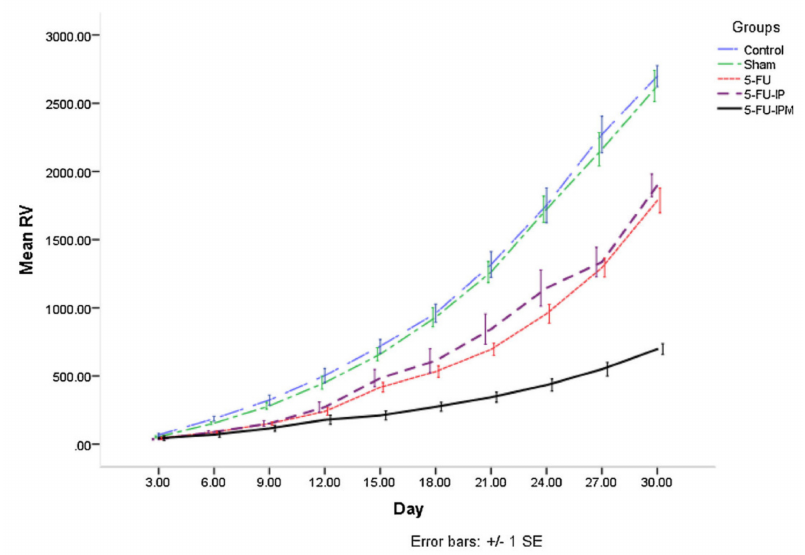
Figure 4. Tumor growth curves of tumor-bearing mice that received di ff erent treatments. RV—relative volume; Sham—non-implanted MNP; 5-FU—5-fluorouracil; 5-FU–IP—5-fluorouracil imprinted polymer; 5-FU–IPM—5-fluorouracil imprinted polymer with a magnetic field [65] (reprinted with permission of Elsevier,